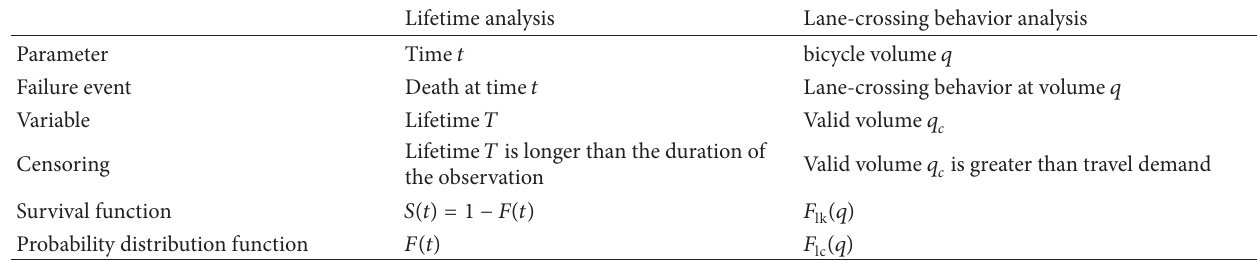
Table 1: Analogy between lifetime data analysis and bicyclist behavior